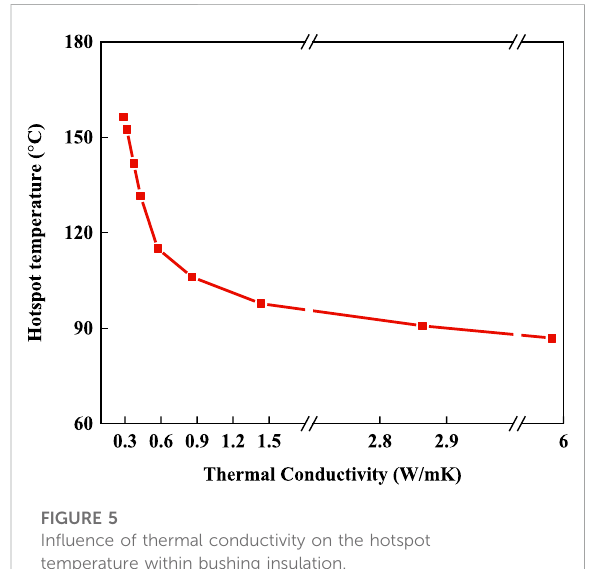
FIGURE 5 In fl uence of thermal conductivity on the hotspot temperature within bushing